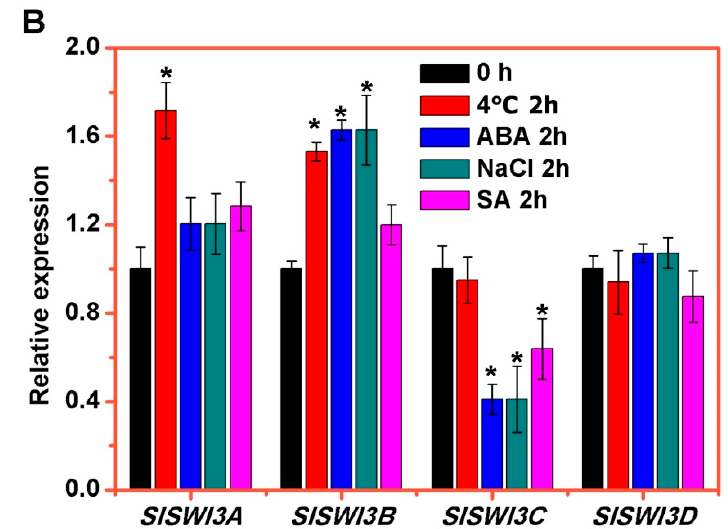
Figure 3. The expression patterns SlSWI3s . ( A ) Tissue-specific expression patterns of SlSWI3s . Heat map of RNA-seq expression data from bud (B), flower (F), leaf (L), root (R), 1 cm_fruit (1), 2cm_fruit (2), 3cm_fruit (3), mature green fruit (MG), berry at breaker stage (Br), and berry ten days after breaking (B + 10). The expression values are measured as reads per kilobase of the exon model per million mapped reads (RPKM). ( B ) Expression profiles of SlSWI3s under responding to hormones, salt, and cold tested by qRT-PCR. Seedlings of two-week-old plate-cultured plants were treated with SA (2 mM), ABA (100 μ M), NaCl (200 mM), and cold (4 °C) for 2 h and collected for total RNA isolation. qRT-PCR was amplified using gene-specific primers. The tomato ACTIN ( Solyc03g078400 ) was used as an internal control. Error bars indicate the SE. Asterisks indicate significant difference from wild-type plants ( p < 0.05, Student’s t test). The data are representative from three independent experiments.